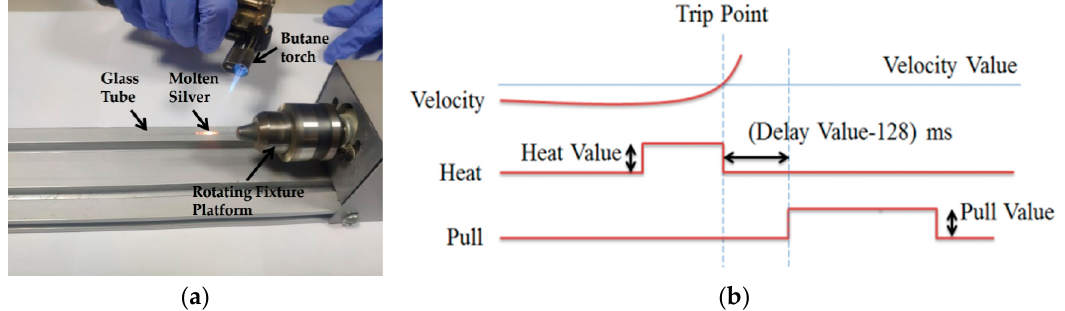
Figure 2. ( a ) Picture of the rotating fixture platform adopted in the melting process. ( b ) A typical pull cycle based on the P-2000 laser-based micropipette puller system.